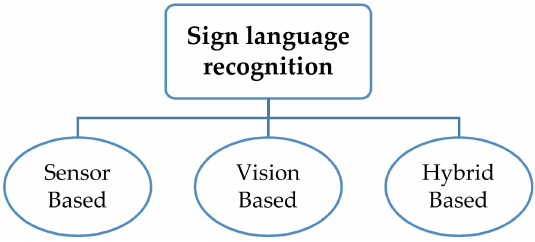
Figure 2. Sign language recognition